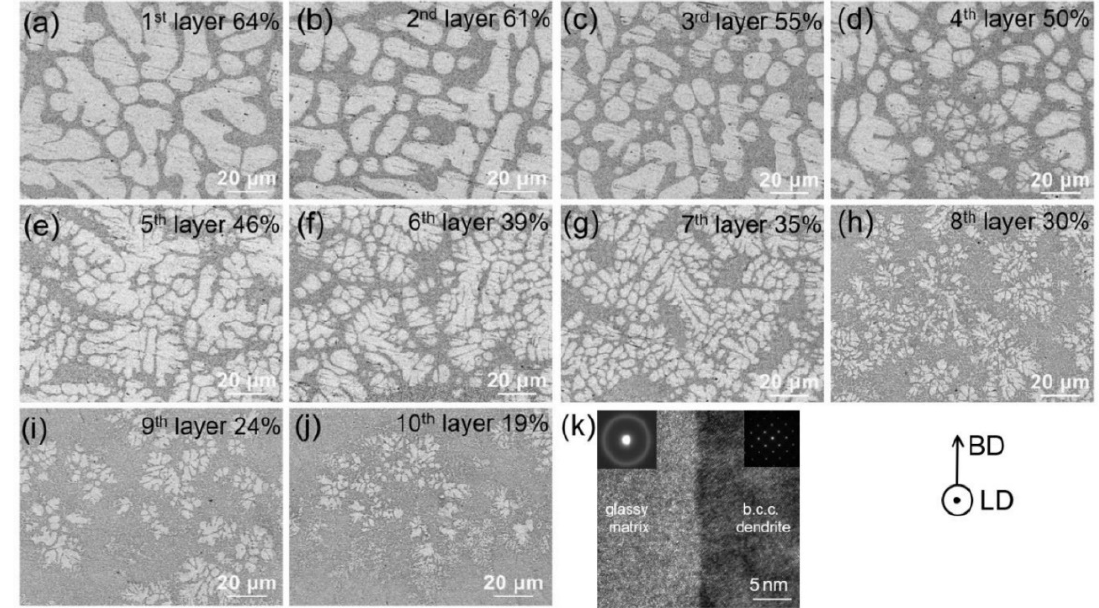
Figure 36. ( a – j ) BSE images of the microstructure of each layer of DH3 (BMGC) fabricated via DED, the 1st layer was the top layer; ( k ) high-resolution TEM characterization of the interface between amorphous and crystalline phases. Reproduced from [102], with permission from Elsevier, 2021.